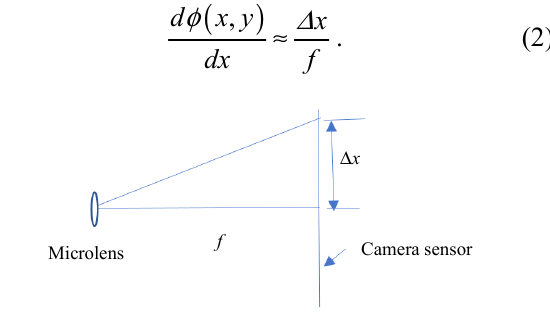
Fig. 3 Schematic of the focal spot displacement for a single